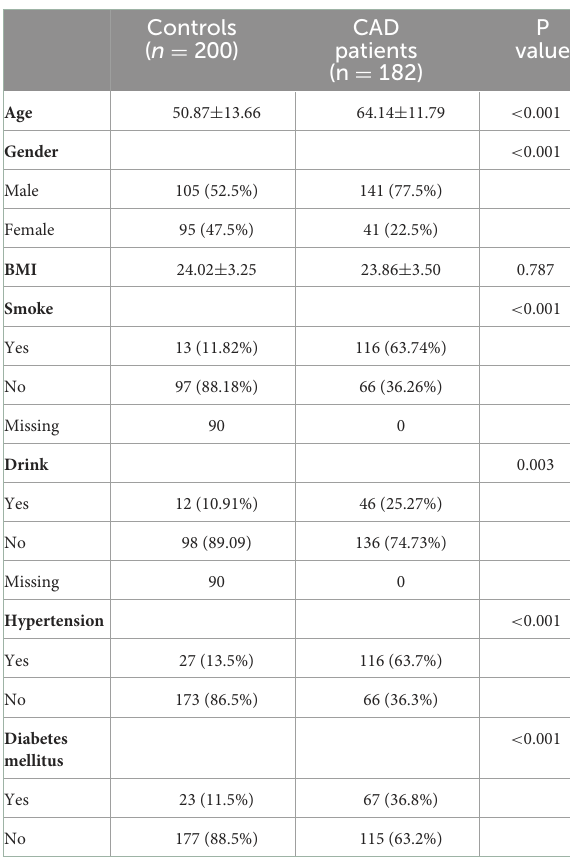
TABLE 1 Clinical characteristics of CAD patients and non-CAD controls metabolizer